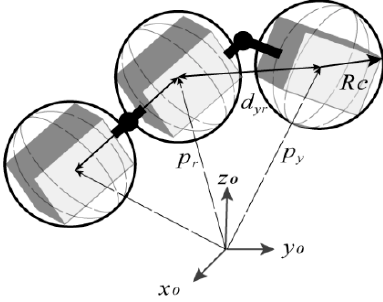
Figure 6. Schematic diagram of the collision detection model.